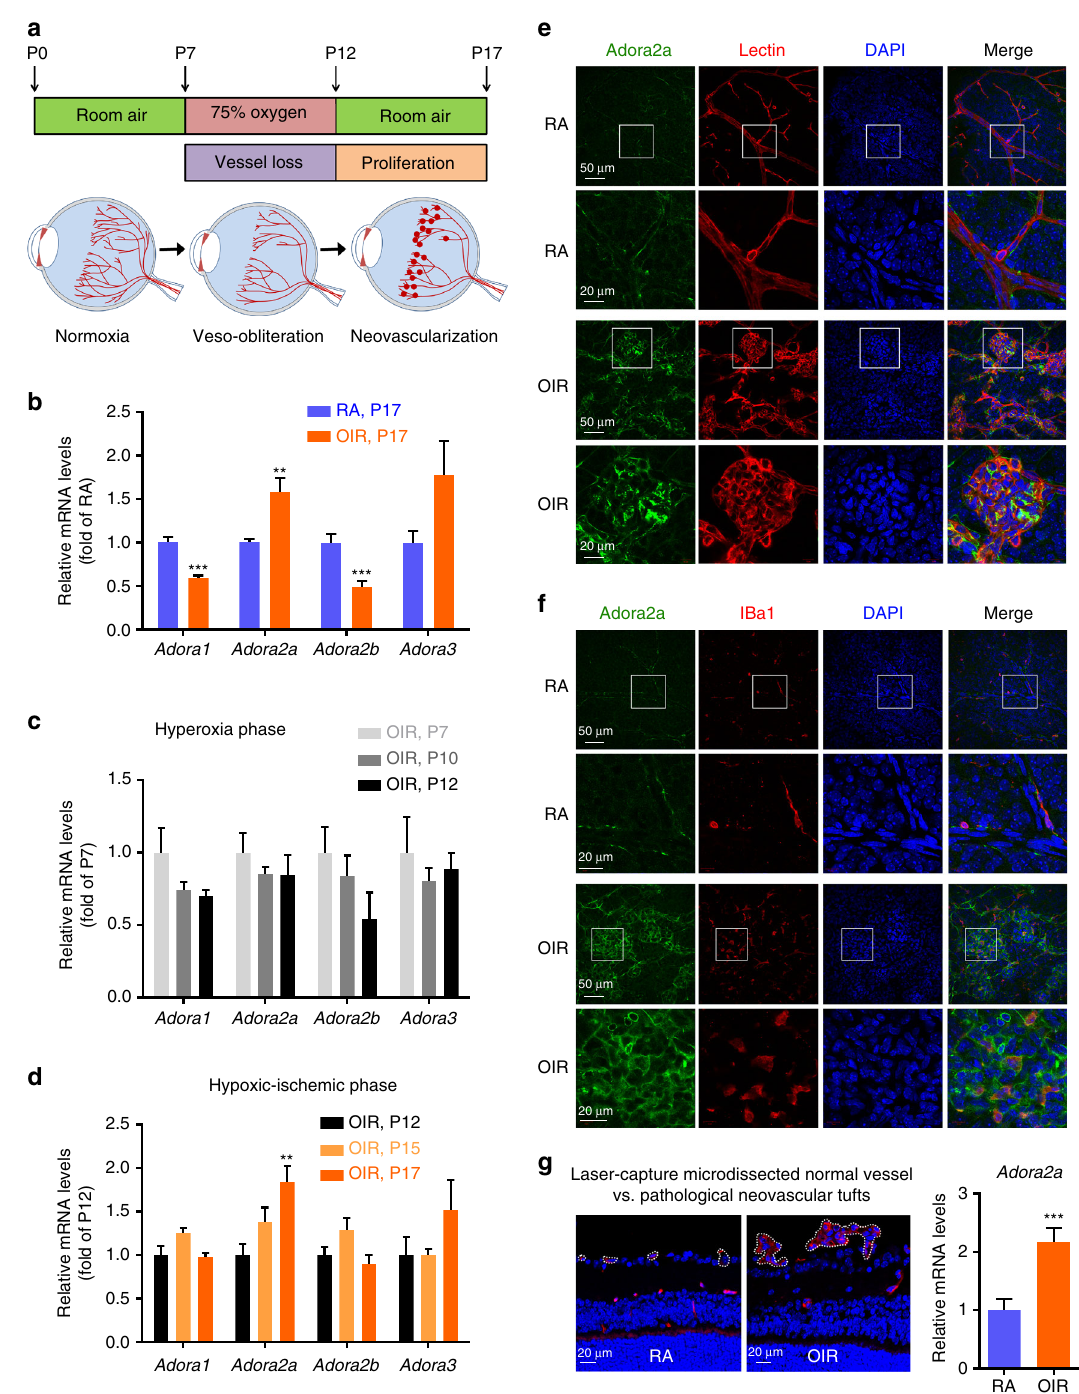
Fig. 1 Localization and expression of Adora2a in rodent proliferative retinopathy. a Schematic illustration of mouse OIR model. Neonatal mice with nursing mothers were exposed to 75% O 2 from postnatal day (P) 7 to P12, followed by room air ( RA ) with maximum neovascularization at P17. b Real-Time PCR analysis of Adora1 , Adora2a , Adora2b , and Adora3 mRNA expression in the whole retina. Retinas were from RA or OIR mice at P17. *** P < 0.001 vs. RA group ( n = 7 mice per group). c , d Real-Time PCR analysis of adenosine receptor mRNA expression in the whole retina. Retinas were obtained from mice at the times indicated. Data were normalized to both the expression of internal control and to gene mRNA expression of each RA control at each time point. ** P < 0.01 vs. P12 ( n = 4 mice per group for c and n = 7 mice per group for d ). e , f Localization and expression of Adora2a in the RA and OIR retinas. Retinopathy was induced in wild-type mice. P17 RA and OIR retinas were stained with Adora2a ( green ), isolectin B4 (Lectin, red , vessel, e ), or IBa1 ( red , macrophages/microglias, f ) and DAPI ( blue , nuclei). In all, 2nd and 4th rows are magni fi cation of the boxed regions in the 1st and 3rd rows, respectively. Scale bar : 50 μ m ( 1st and 3rd rows) and 20 μ m ( 2nd and 4th rows). g Real-Time PCR analysis of Adora2a mRNA expression in laser-capture microdissected pathological neovessels (tufts) from OIR mice compared with normal vessels from control mice raised in RA at P17. *** P < 0.001 vs. RA ( n = 4 per group). Data are represented as means ± s.e.m. Statistical signi fi cance was determined by unpaired Student ’ s t -test (for b , g ) and one-way ANOVA followed by Bonferroni test (for c , d